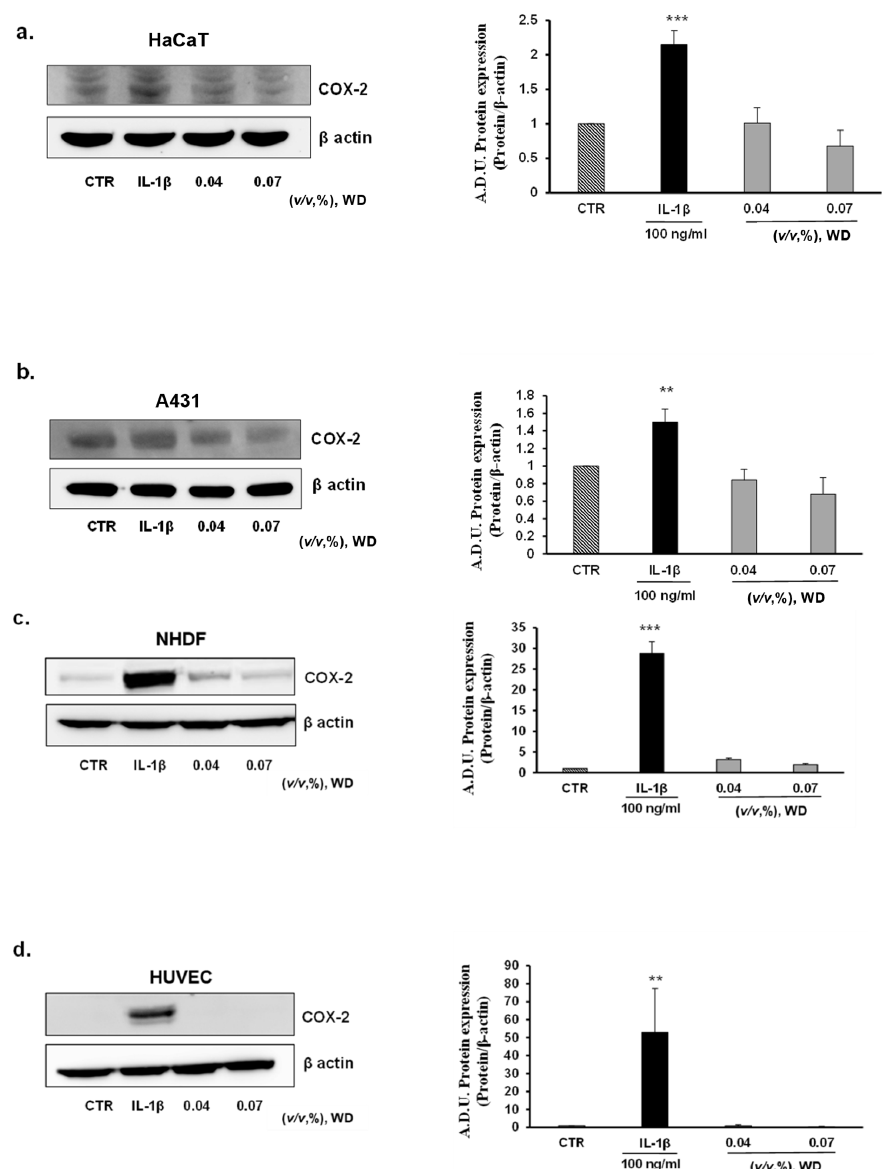
Figure 5. Effect of prolonged exposure to WD on the expression of the inflammatory marker COX-2. Keratinocytes HaCaT ( a ), model of mucosal epithelial cells A431 ( b ), fibroblasts NHDF ( c ) and endothelial cells HUVEC ( d ) were treated with no cytotoxic doses of WD, 0.04–0.07%. Results were compared with untreated cells and cells under a fixed dose of Interleukin-1β (IL-1β, 100 ng/mL), for 24 h. The treatments were performed under experimental condition of medium with 1% FBS. Signals were evaluated through Western blot and normalized on β-actin. Data were reported as arbitrary densitometry units (A.D.U.) ± SD of each signal/ β-actin vs. basal control. (n = 3). ** p < 0.01, *** p < 0.01 vs. untreated cells (CTR).